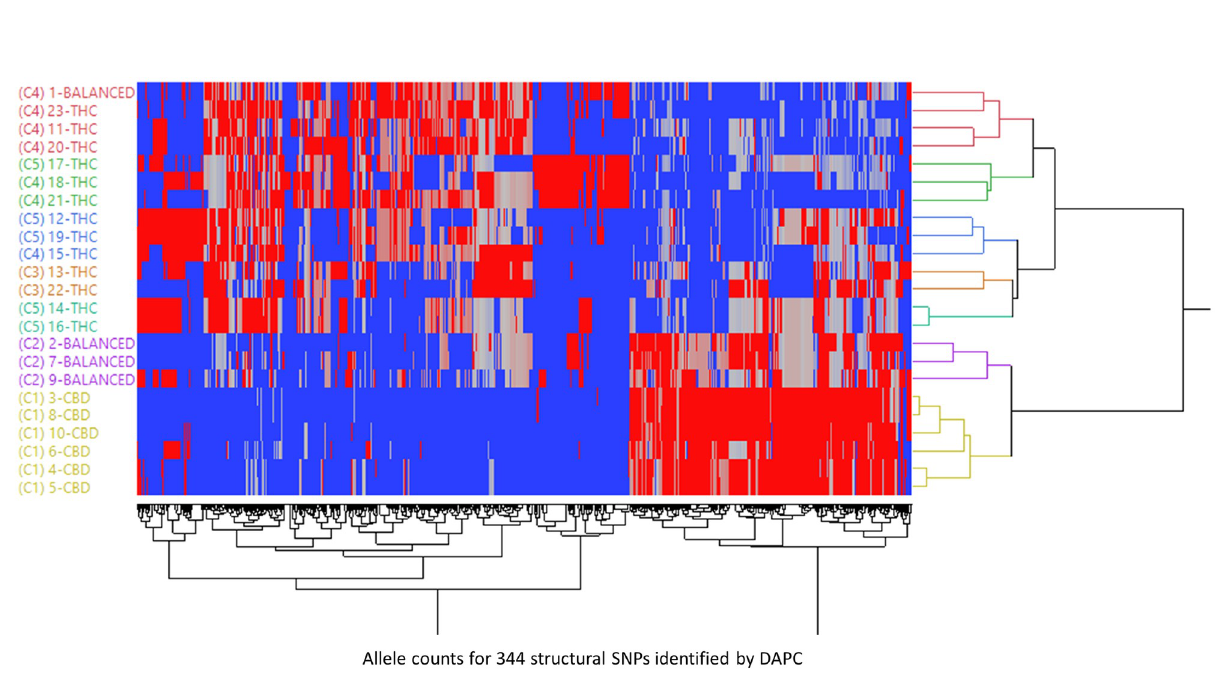
Fig 5. Hierarchical clustering of 23 strains based on the allele counts for 344 structural SNPs identified by DAPC.